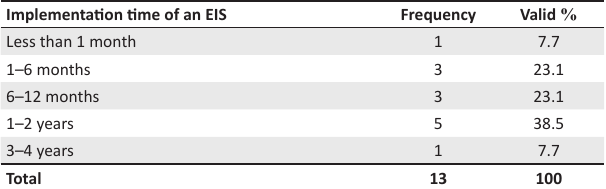
TABLE 2: Implementation time of Executive Information Systems (EISs) in the near future.